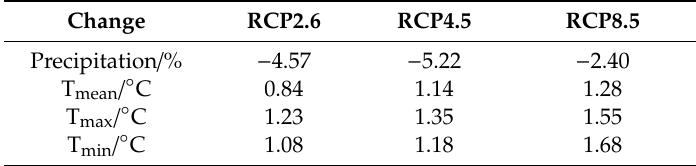
( c ) Figure 5. Spatial variation patterns of the T max under ( a ) RCP2.6; ( b ) RCP4.5; and ( c ) RCP8.5. Different from higher increases of the T max than those of the T min under the RCP 2.6 and RCP 4.5 scenarios, the increases of the T min at some stations were higher than those of the T max under the RCP8.5 scenario, including Yumen Town (1.76 °C), Jinta (1.84 °C), and Jiuquan (1.75 °C). Areas with relatively small increases of the T min included Jikede, Yeniugou, Yongchang, Gangcha, and Mengyuan. As shown in Figure 6, the highest increase of the T min situated in the southwestern mountainous area. However, in contrast to the spatial variation patterns of the T mean and T max , T min rose the most in the middle reaches. Referring to Table 1, compared with the reference period, the T min during the future period under RCP2.6, RCP4.5, and RCP8.5 all increased by 1.08 °C, 1.18 °C, and 1.68 °C, respectively.